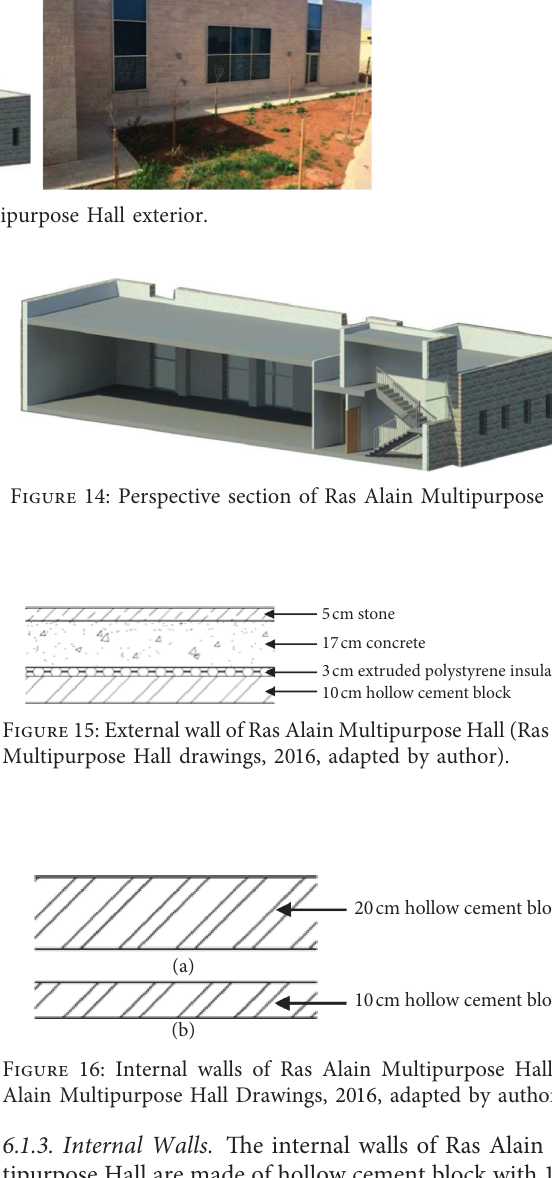
Figure 12: Ground floor plan with zoning Ras Alain Multipurpose Hall.